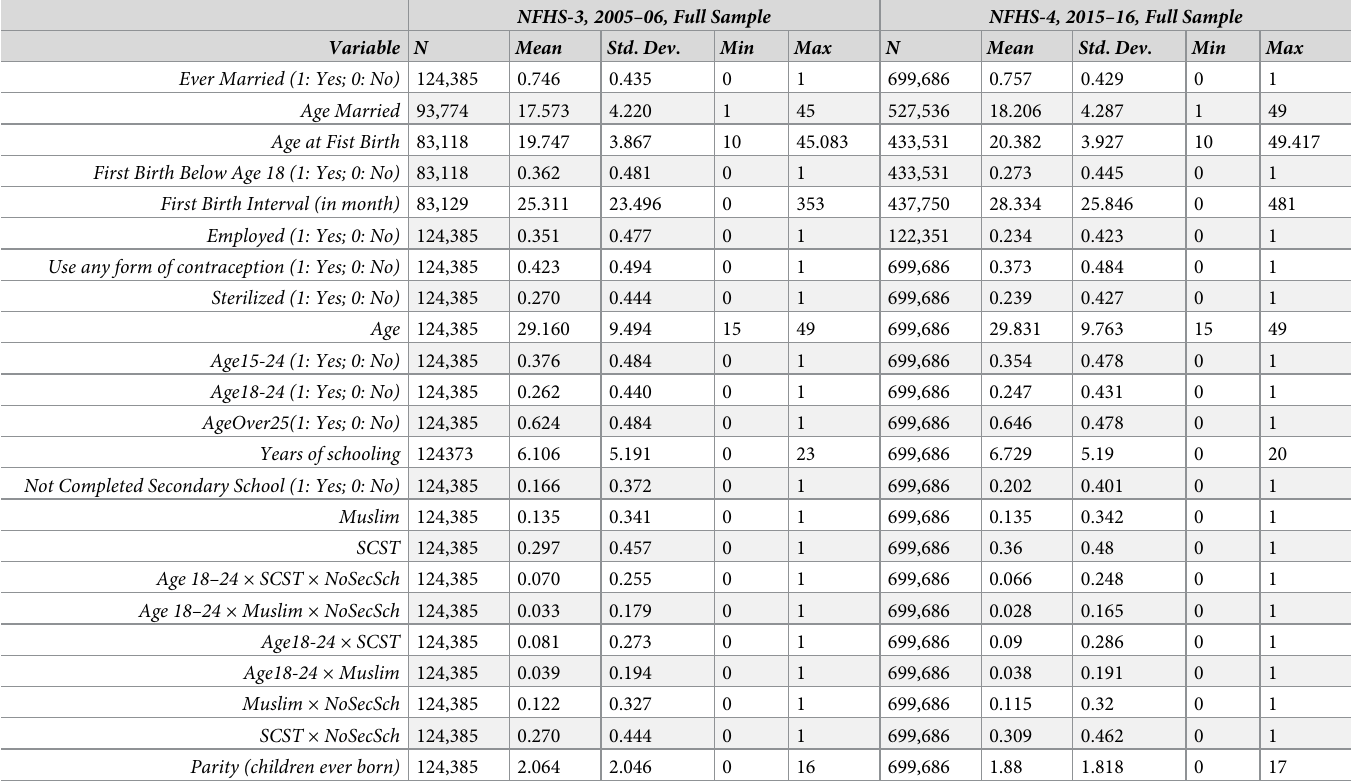
Table 2. Summary statistics of key variables drawn from NFHS-3 and